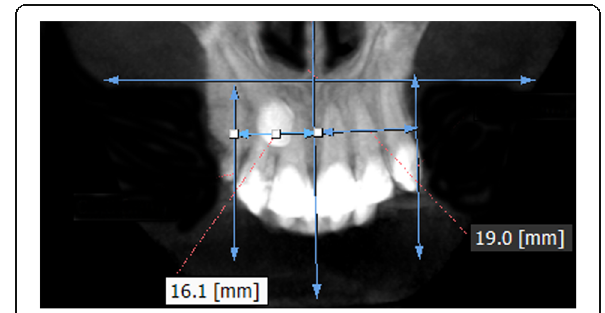
Fig. 4 Basal lateral width. Measured in millimeters from the anterior nasal spine to the dentoalveolar outermost rim on the side of the impacted canine and canine without impaction